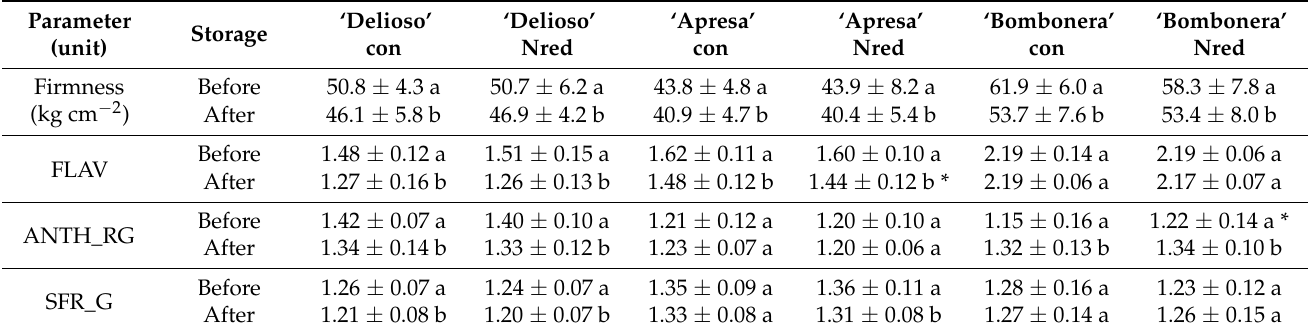
Table 3. External quality parameters assessed by non-invasive measurements of tomato fruits of three cocktail varieties grown with normal (con) and reduced (Nred) N supplies, immediately after harvest (before storage) and after 8 days of storage at 12 ◦ C (after storage). Means of N = 22 to 36 for firmness, and N = 31 to 58 ± SD for FLAV, ANTH_RG and SFR_G. Different letters indicate significant differences due to storage within a variety and N supply. Asterisks indicate significant differences due to N supply within a variety and storage (two-way ANOVA with Tukey pairwise comparison, or Kruskal–Wallis test with Mann–Whitney pairwise comparison; at α = 0.05).